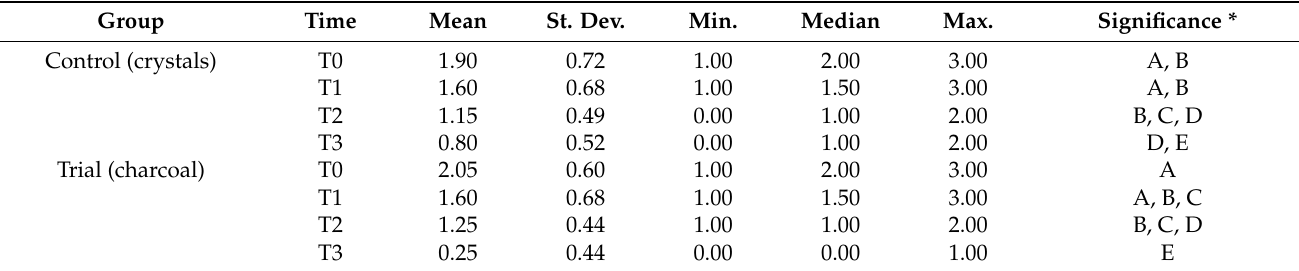
Table 7. Descriptive statistics of LSI-E, and significant intragroup and intergroup differences assessed by the Dunn’s post hoc test. * The means with the same letters are not significantly different ( p >